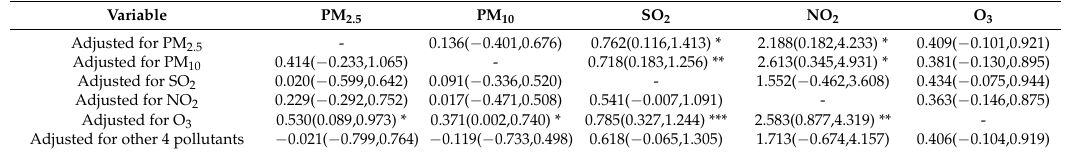
Table 4. The percent change and 95% CI for respiratory disease hospitalization associated with a 10- µ g/m 3 increases in air pollutants concentrations at different best lag days in multi-pollutant models. Variable PM 2.5 PM 10 SO 2 NO 2 O 3 Adjusted for PM 2.5 - 0.136( − 0.401,0.676) 0.762(0.116,1.413) * 2.188(0.182,4.233) * 0.409( − 0.101,0.921) Adjusted for PM 10 0.414( − 0.233,1.065)